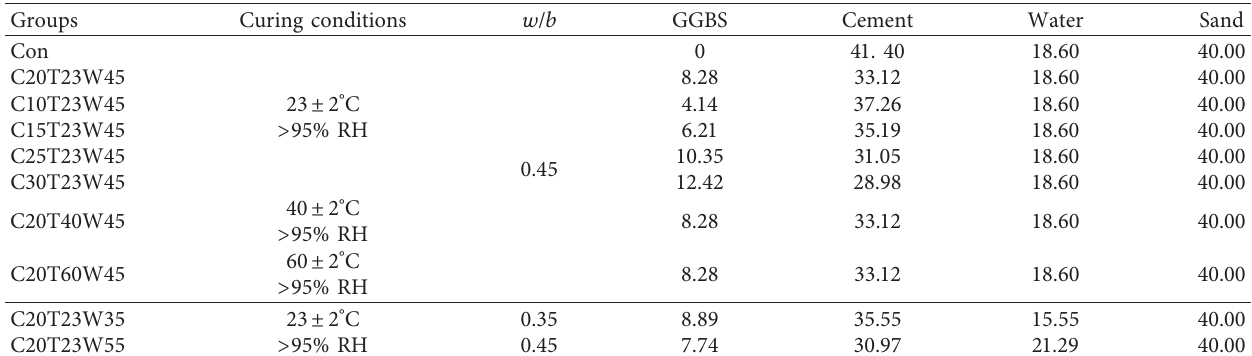
Figure 1: Particle size distributions of cement and GGBS. Table 2: Mixing proportions.